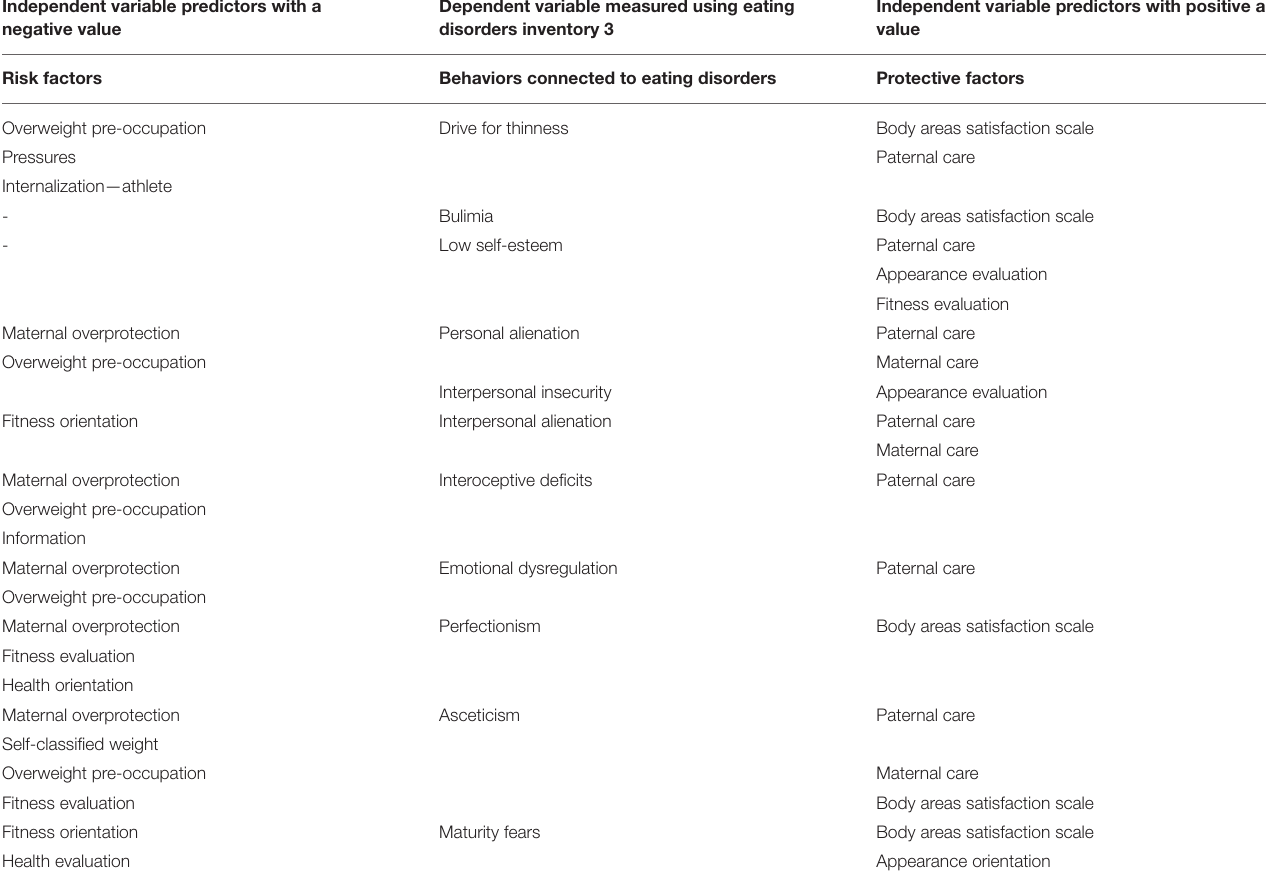
TABLE 4 | The summary of protective and risk factors for the development of eating